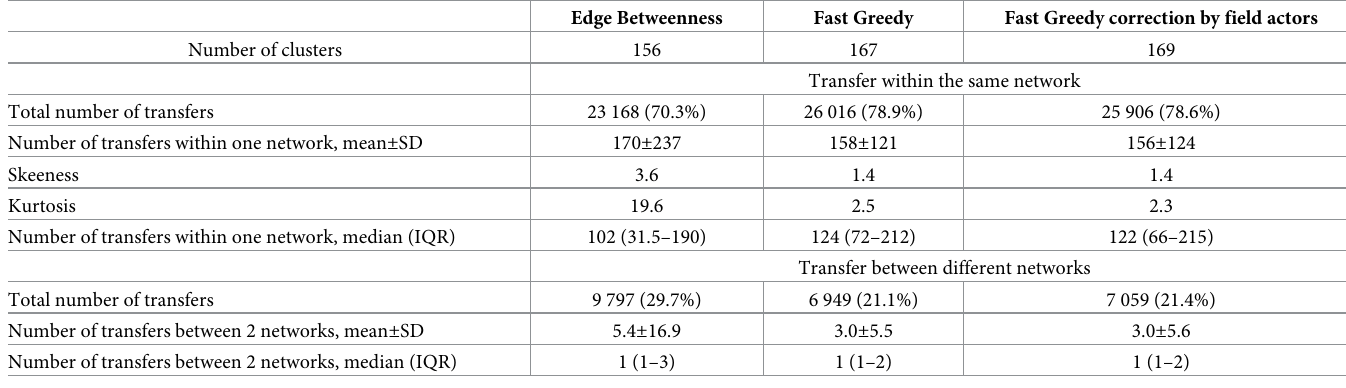
Table 1. Comparison of the Edge Betweenness and Fast Greedy methods for analysing dialysis network activities in France. Edge Betweenness Fast Greedy Fast Greedy correction by field actors Number of